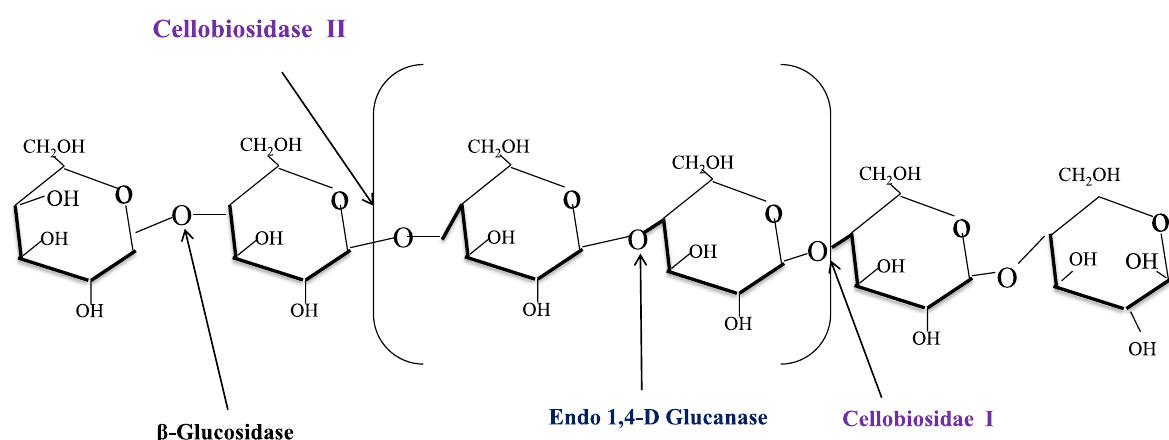
Fig. 1 The structures of cellulase (Linton 2020)